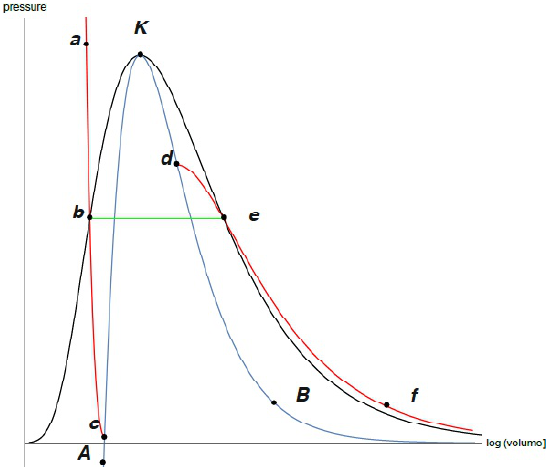
Fig. 3. Metastable states and their unstable bound- ary according to Landau